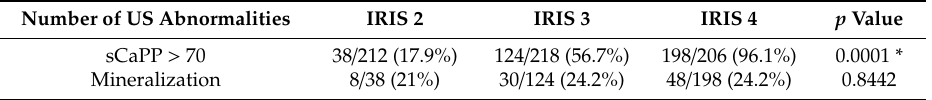
Table 4. Kruskall Wallis test of the prevalence of elevated sCaPP ( > 70 mg 2 / dL 2 ) in dogs showing kidney mineralization, at di ff erent CKD IRIS